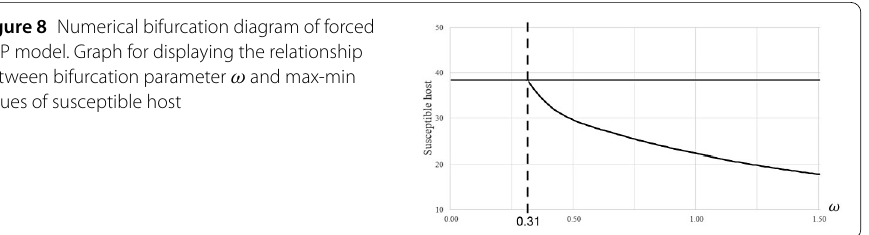
Figure 8 Numerical bifurcation diagram of forced SISP model. Graph for displaying the relationship between bifurcation parameter ω and max-min values of susceptible host